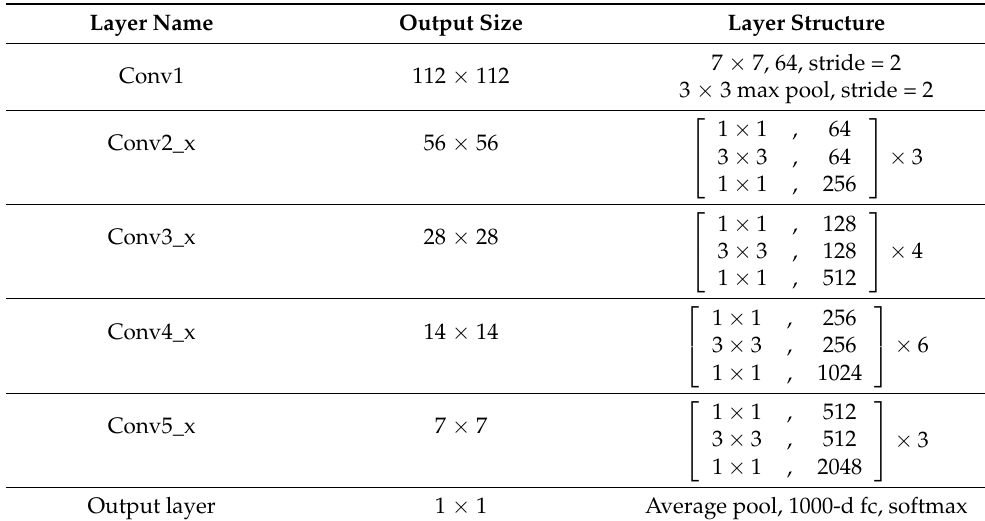
Figure 12. Ship trajectory classification network architecture. Table 4. Ship trajectory classification network structure.